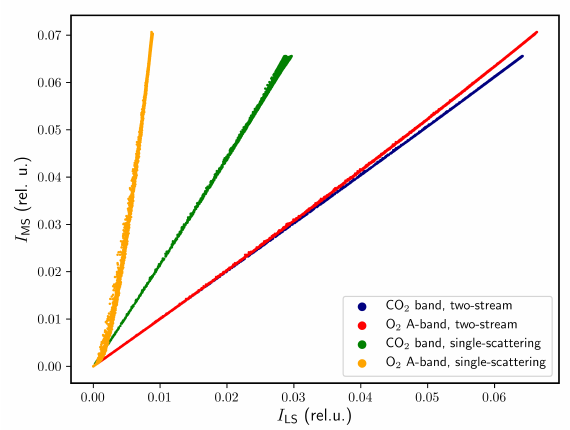
Figure 3. Radiance computed with the multi-stream model as a function of radiances computed by using the low-stream models (two-stream and single-scattering models) for the O 2 A- and CO 2 bands. The figure corresponds to the ‘Aerosol 2’